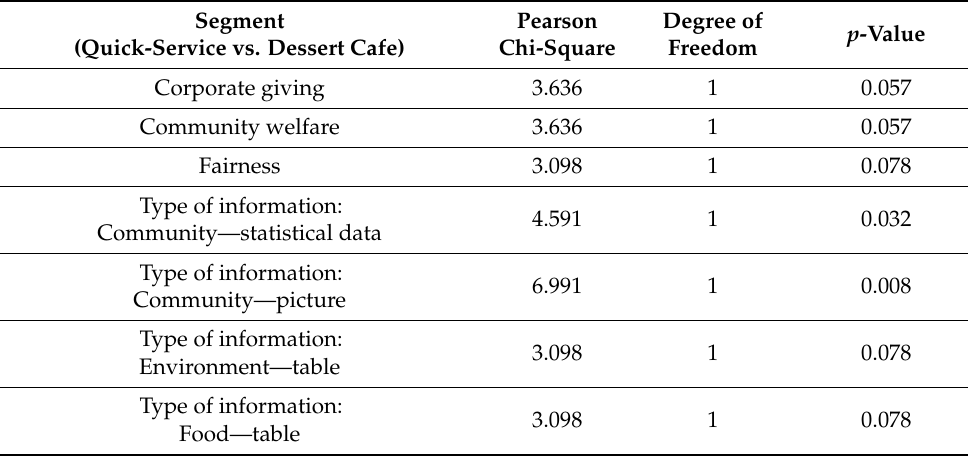
Table 12. Results of chi-square